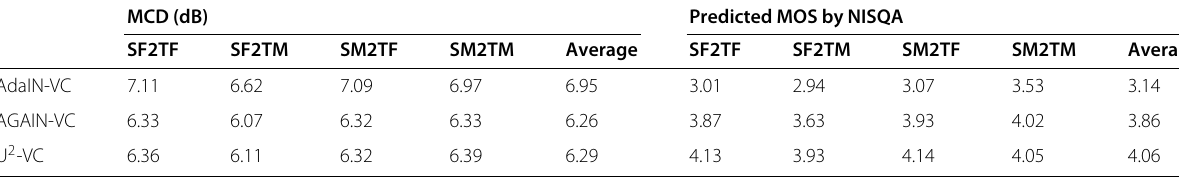
Table 6 Objective comparison results of mono-lingual conversion in seen-to-seen scenario MCD (dB)